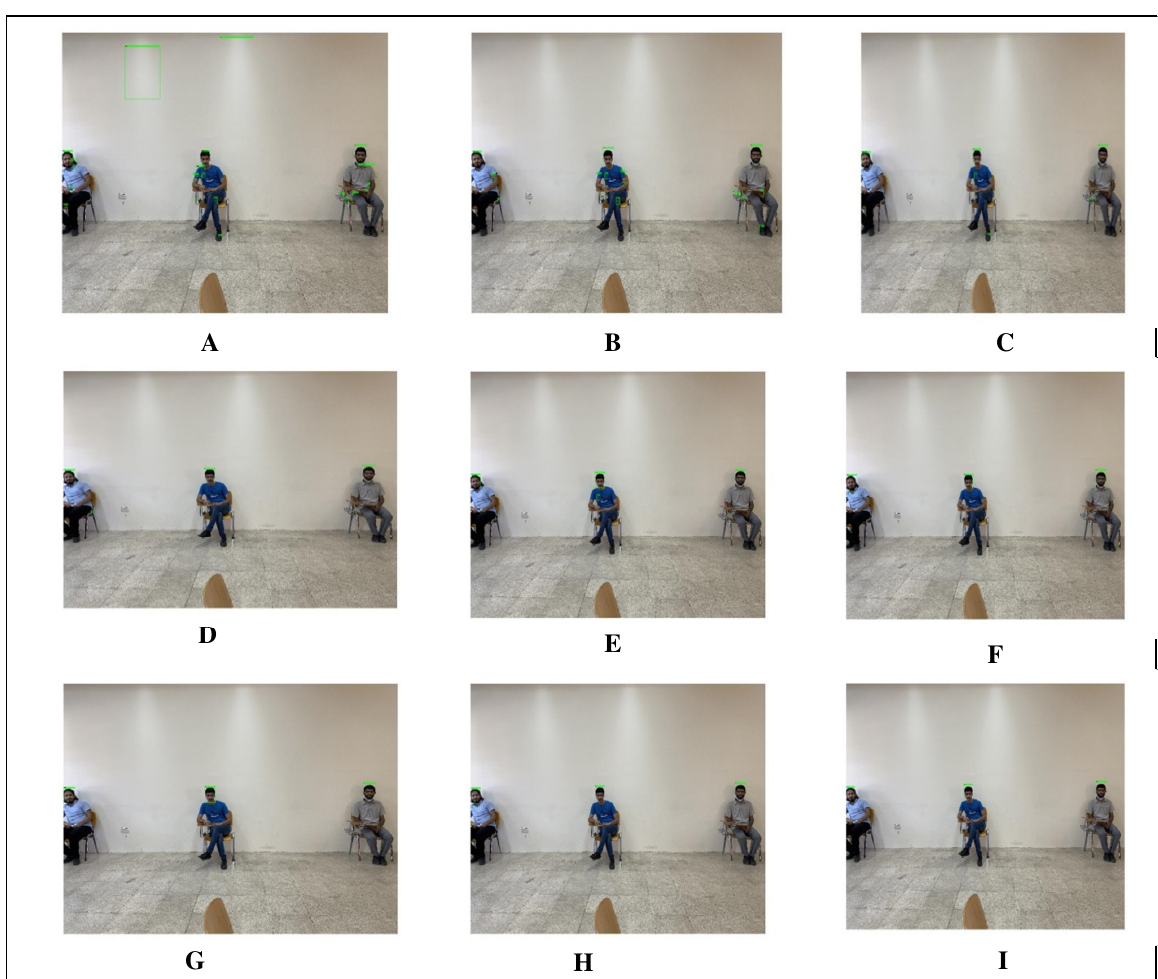
Fig. 8. Results through using different number of Cascaded Stage with different values of False Alarm Rate.